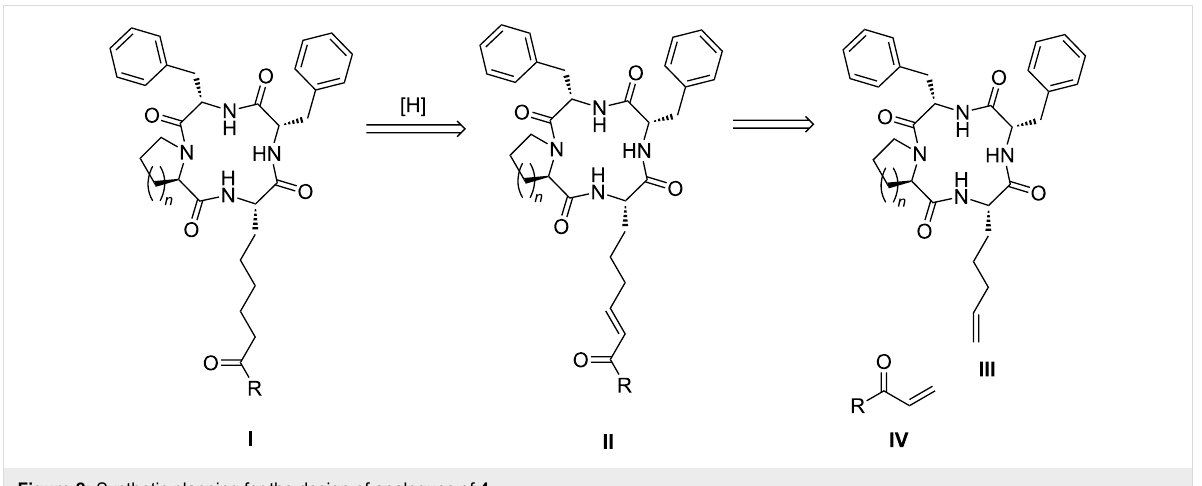
Figure 2: Synthetic planning for the design of analogues of 4